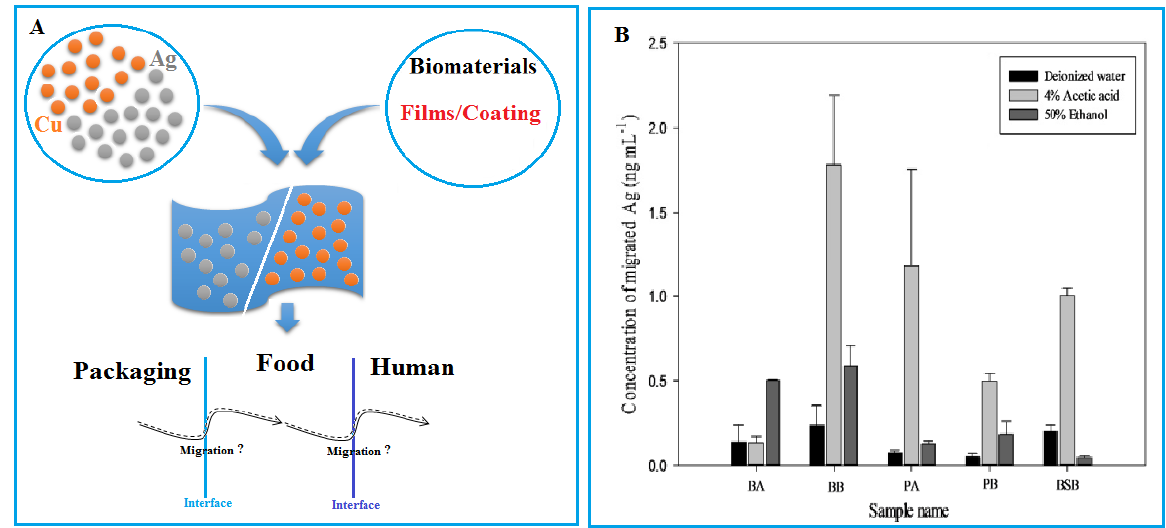
Figure 3. ( A ) The issue of AgNP and CuNPs migration from packaging to foods and from foods to human organs. ( B ) Concentration of migrated AgNPs in three different food simulants from baby bottle A (BA). BA: baby bottle A; BB: baby bottle B; PA: pacifier A; PB: pacifier B; BSB: breast milk storage bag. Reprinted with permission [60]. Copyright 2018 Taylor & Francis.